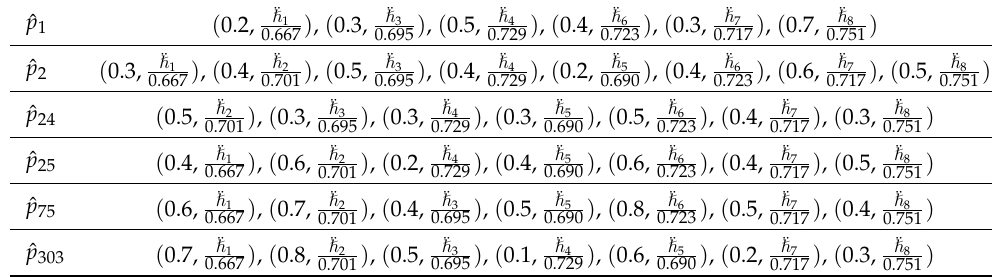
Table 7. Containment of ˆ p i in approximate values of ¨ (cid:125) i .